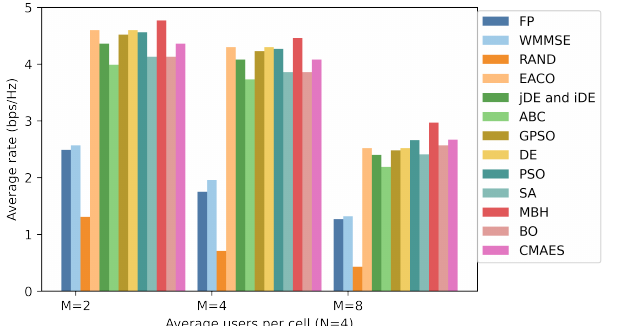
Figure 6. The average rate versus user number per cell.